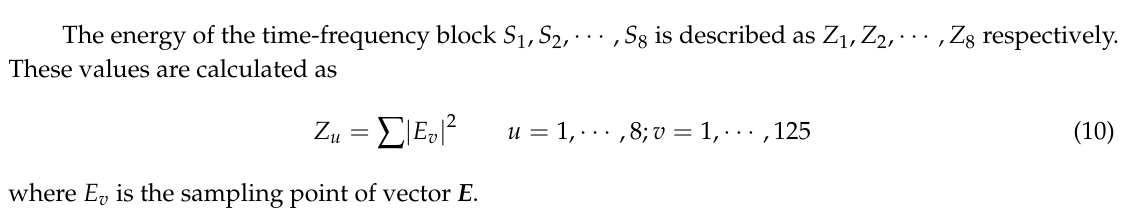
Figure 9. The segmentation of time-frequency plane.